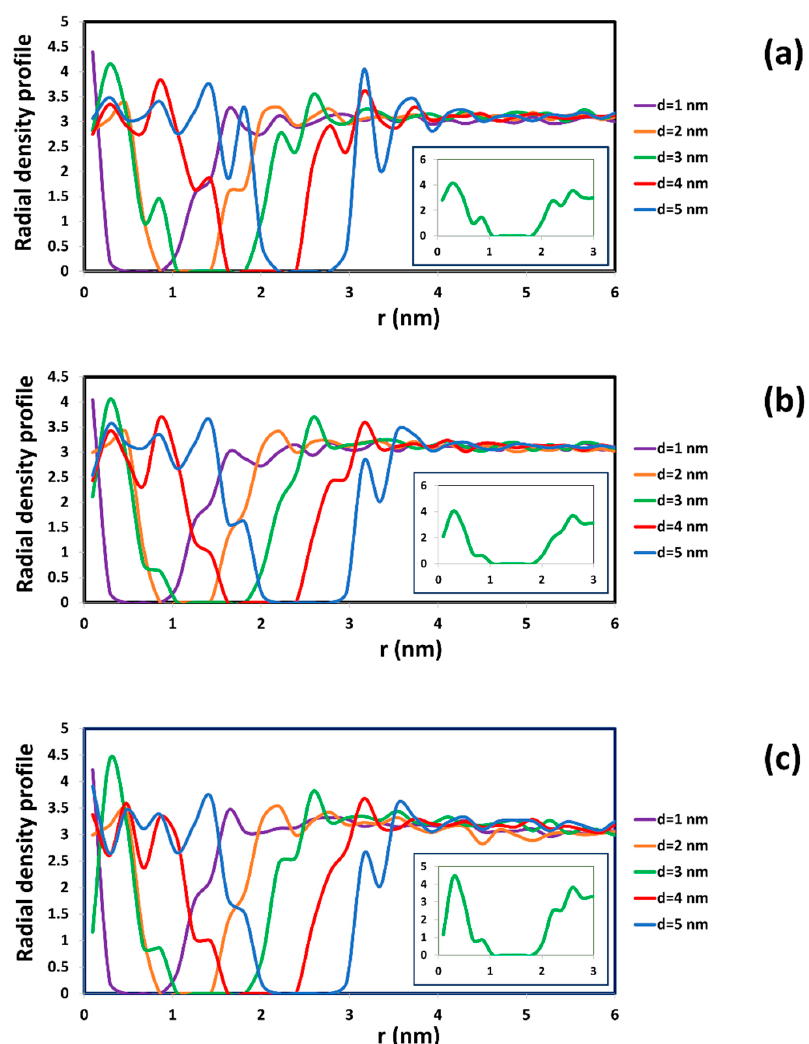
Figure 6. Radial density profile of water inside CNT with SDS adsorption at different total concentration of SDS: 1 wt % ( a ); 2 wt % ( b ); and 3 wt % ( c ). The insets in each figure exhibit enlargements of radial density profile with respect to distance (r) from 0 to 3 nm in case of SWCNT with diameter of 3